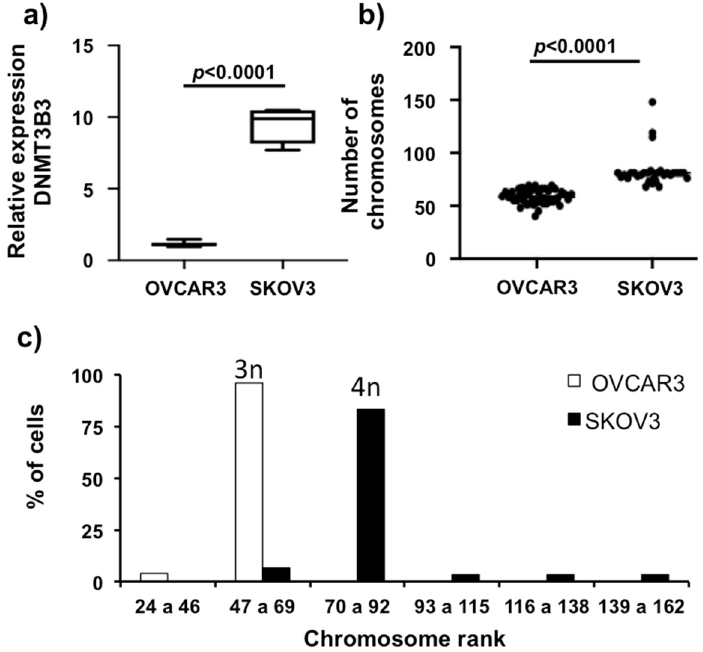
Figure 7. DNMT3B3 overexpression is associated with CIN in OVCAR3 and SKOV3 ovarian carcinoma cells. ( a ) DNMT3B3 mRNA expression by qRT-PCR, ( b ) number of chromosomes, and ( c ) frequency distribution of the number of chromosomes, according to the ploidy ranking, in advanced stages of high-grade serous ovarian carcinoma cell lines: OVCAR3 and SKOV3. The relative expression assay was normalized with GAPDH expression in each case and OSE cell lines as a control. Mann–Whitney U test was used.